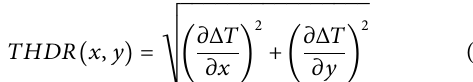
Frontiers in Earth Science |